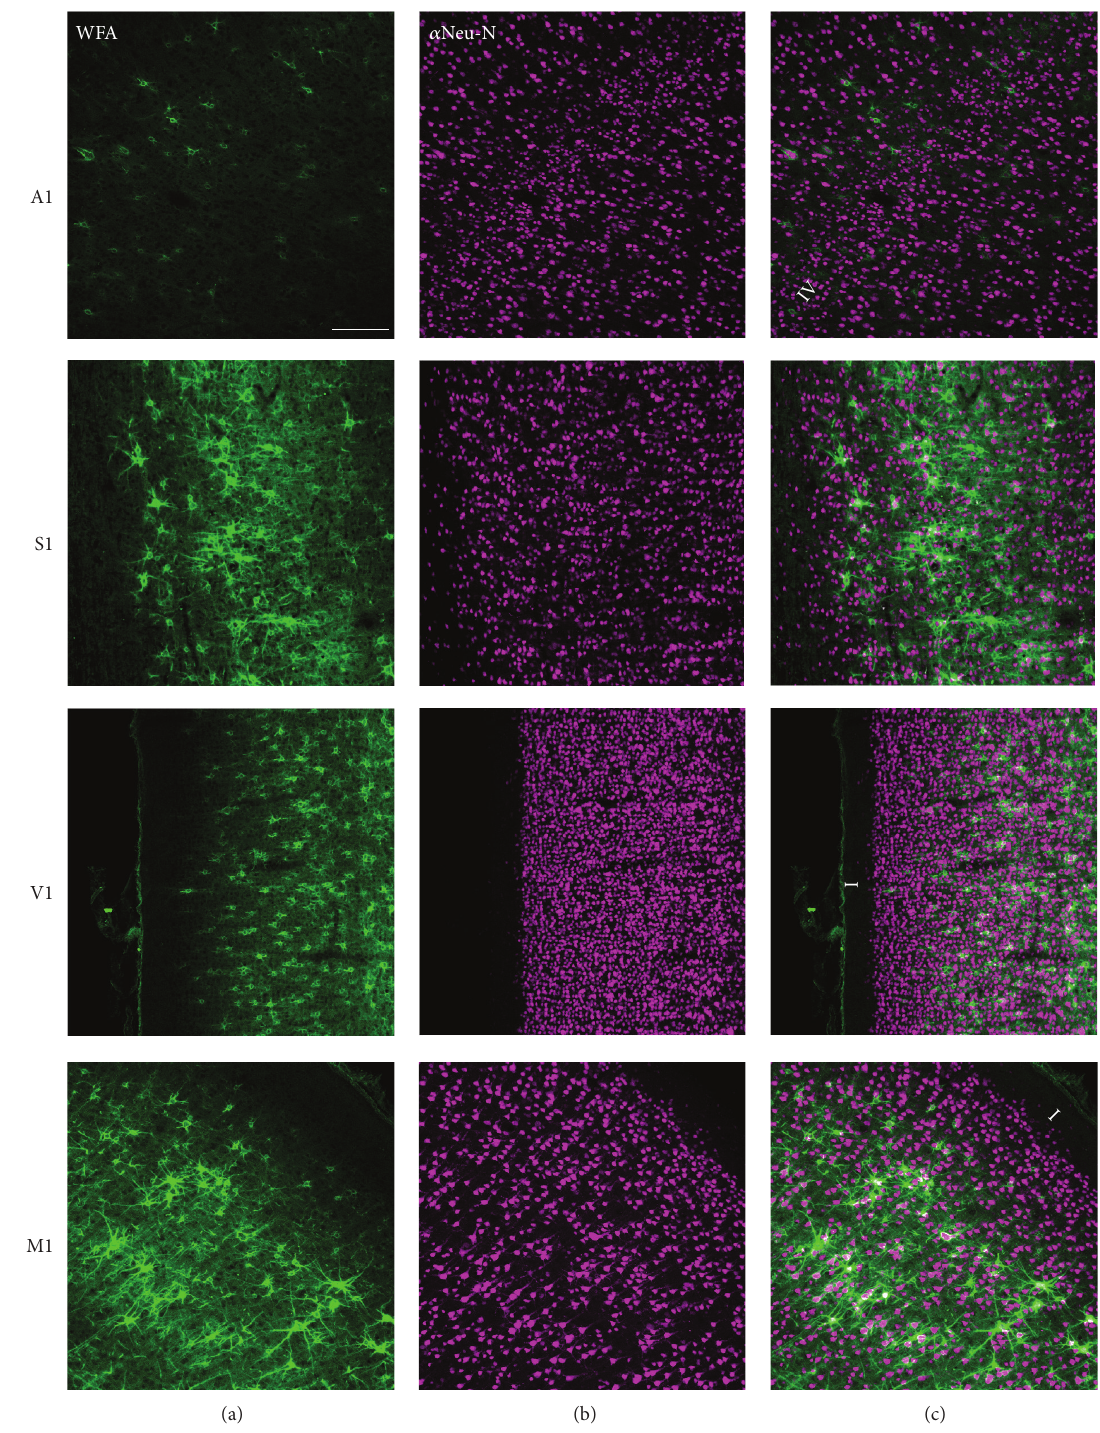
Figure 4: Perineuronal nets in primary sensory and motor cortex. (a) shows perineuronal nets stained with WFA. (b) shows NeuN-labeled neurons. (c) shows merged images of the two. Neurons are predominantly absent from layer I, which is primarily composed of fibers running parallel to the cortical surface. We identify layer I or layer IV, where appropriate, in the rightmost panels. A1: primary auditory cortex, S1: primary somatosensory cortex, V1: primary visual cortex, and M1: primary motor cortex. Scale bar = 200 𝜇